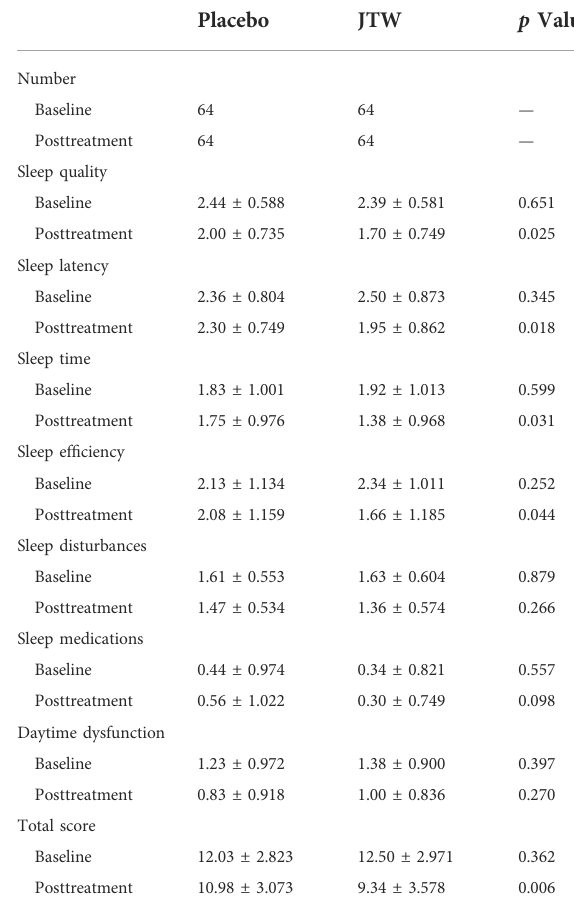
TABLE2ComparisonofPSQIscoresintheparticipantsatbaselineand posttreatment between the JTW and placebo